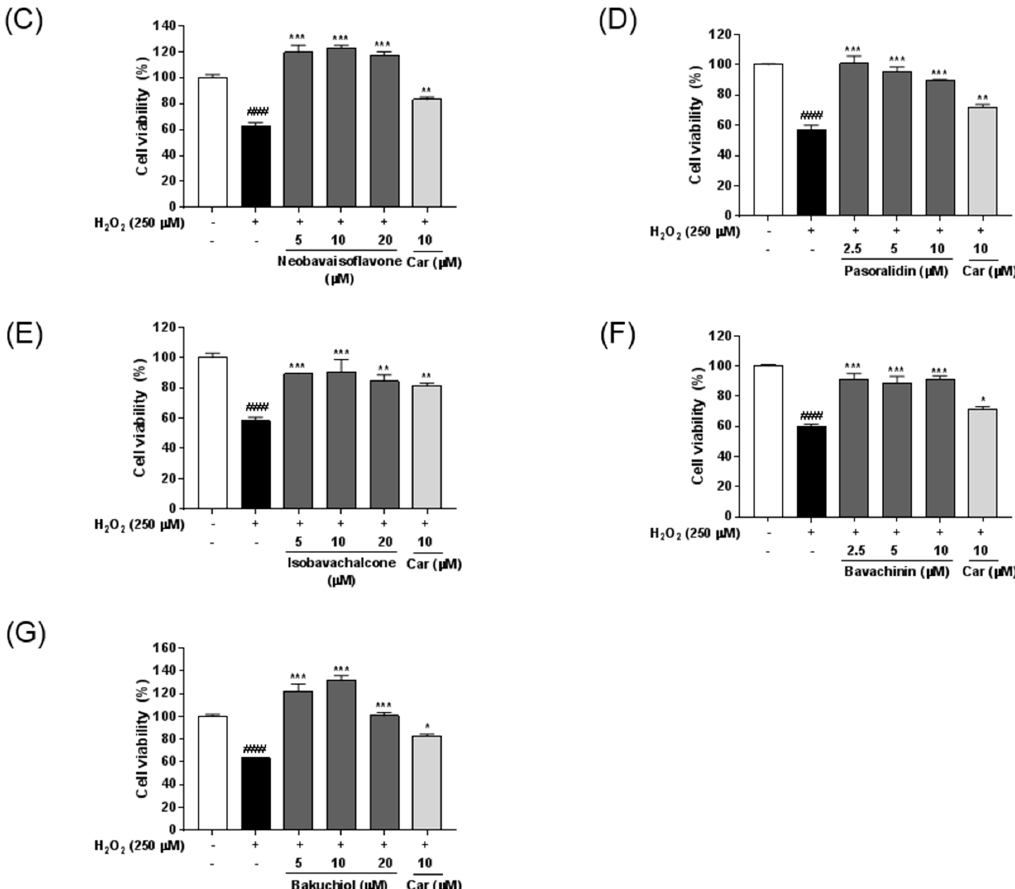
Figure 4. Neuroprotective effects of the seven components from P. corylifolia in H 2 O 2 -treated HT22 cells. Cells were cotreated with various concentrations of each components and H 2 O 2 (250 μ M) for 6 h. Psoralen ( A ); angelicin ( B ); neobavaisoflavone ( C ); psoralidin ( D ); isobavachalcone ( E ); bavachinin ( F ); and bakuchiol ( G ). Cell viability was assessed using CCK-8 assays. Carvedilol (Car) was used as a positive control. The results are expressed as mean ± SEM of three independent experiments. ### p < 0.01 versus vehicle control cells; * p < 0.05, ** p < 0.01, and *** p < 0.001 versus H 2 O 2 -treated cells.